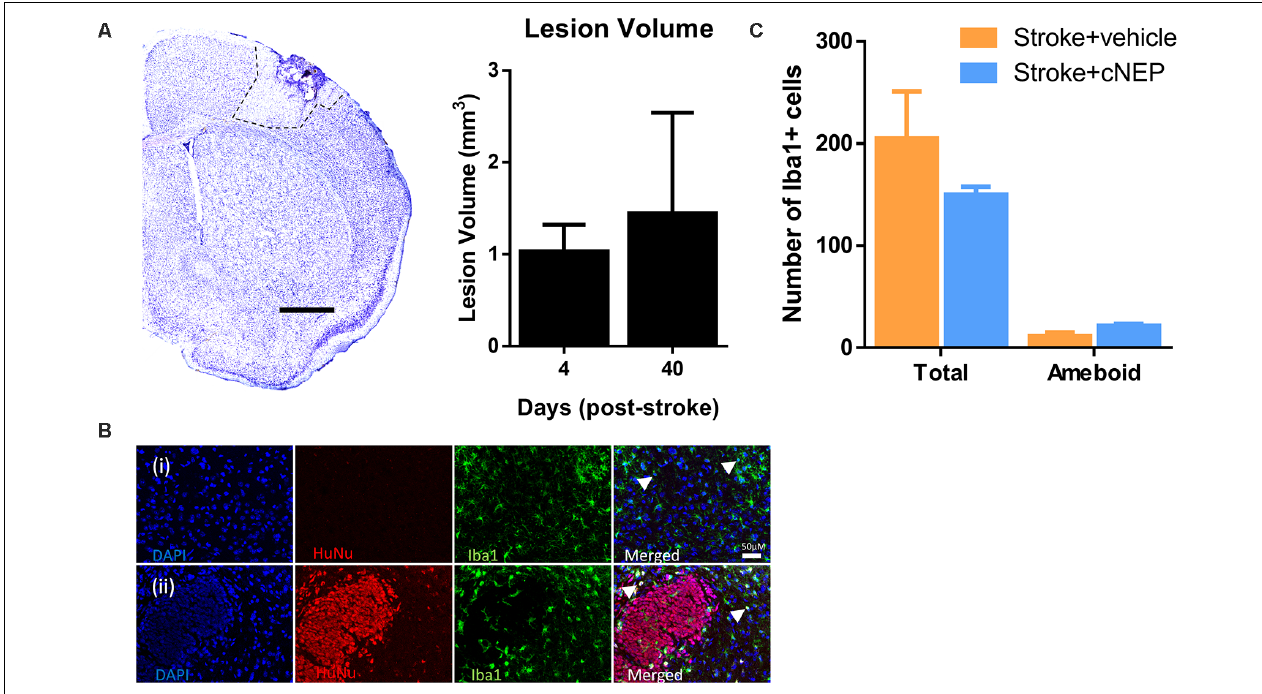
FIGURE 4 | Transplanted cells do not alter the lesion volume or the inflammatory cell response. (A) Cresyl violet cross section of the stroke injured cortex on post-stroke day 4 (PSD4). Dotted line delineates the stroke lesion. The lesion volume is not significantly different between PSD4 (pre-transplant) and PSD40 (Stroke + cNEPs). n = 3 mice/group; data represents mean ± SEM; Student’s t -test. Scale bar = 500 µ m. (B) Iba1 + inflammatory microglia were stained in Stroke + vehicle (i) and Stroke + cNEP (ii) treated mice on PSD8. Scale bar = 50 µ m. (C) Quantification of iba1 + cells showed no significant difference in the number of Iba1 + cells or activated Iba1 + cells between groups ( n = 3 mice/group). Data represents mean ± SEM; Student’s t -test. Arrowheads indicate iba1 + amoeboid shaped